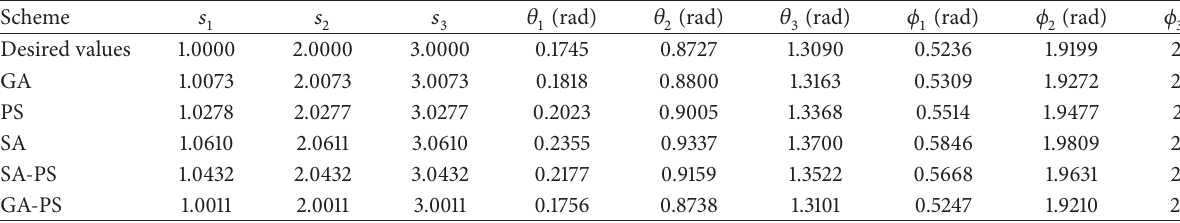
Table 5: Performance of 1-L-type array for 3 sources [15].